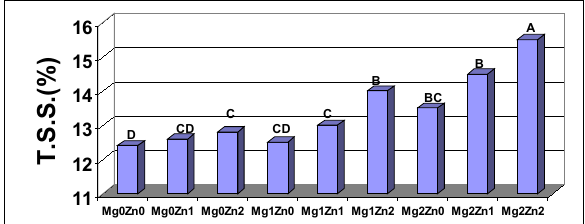
Fig. 2. Effects of foliar application of Mg and Zn on TSS of grapes